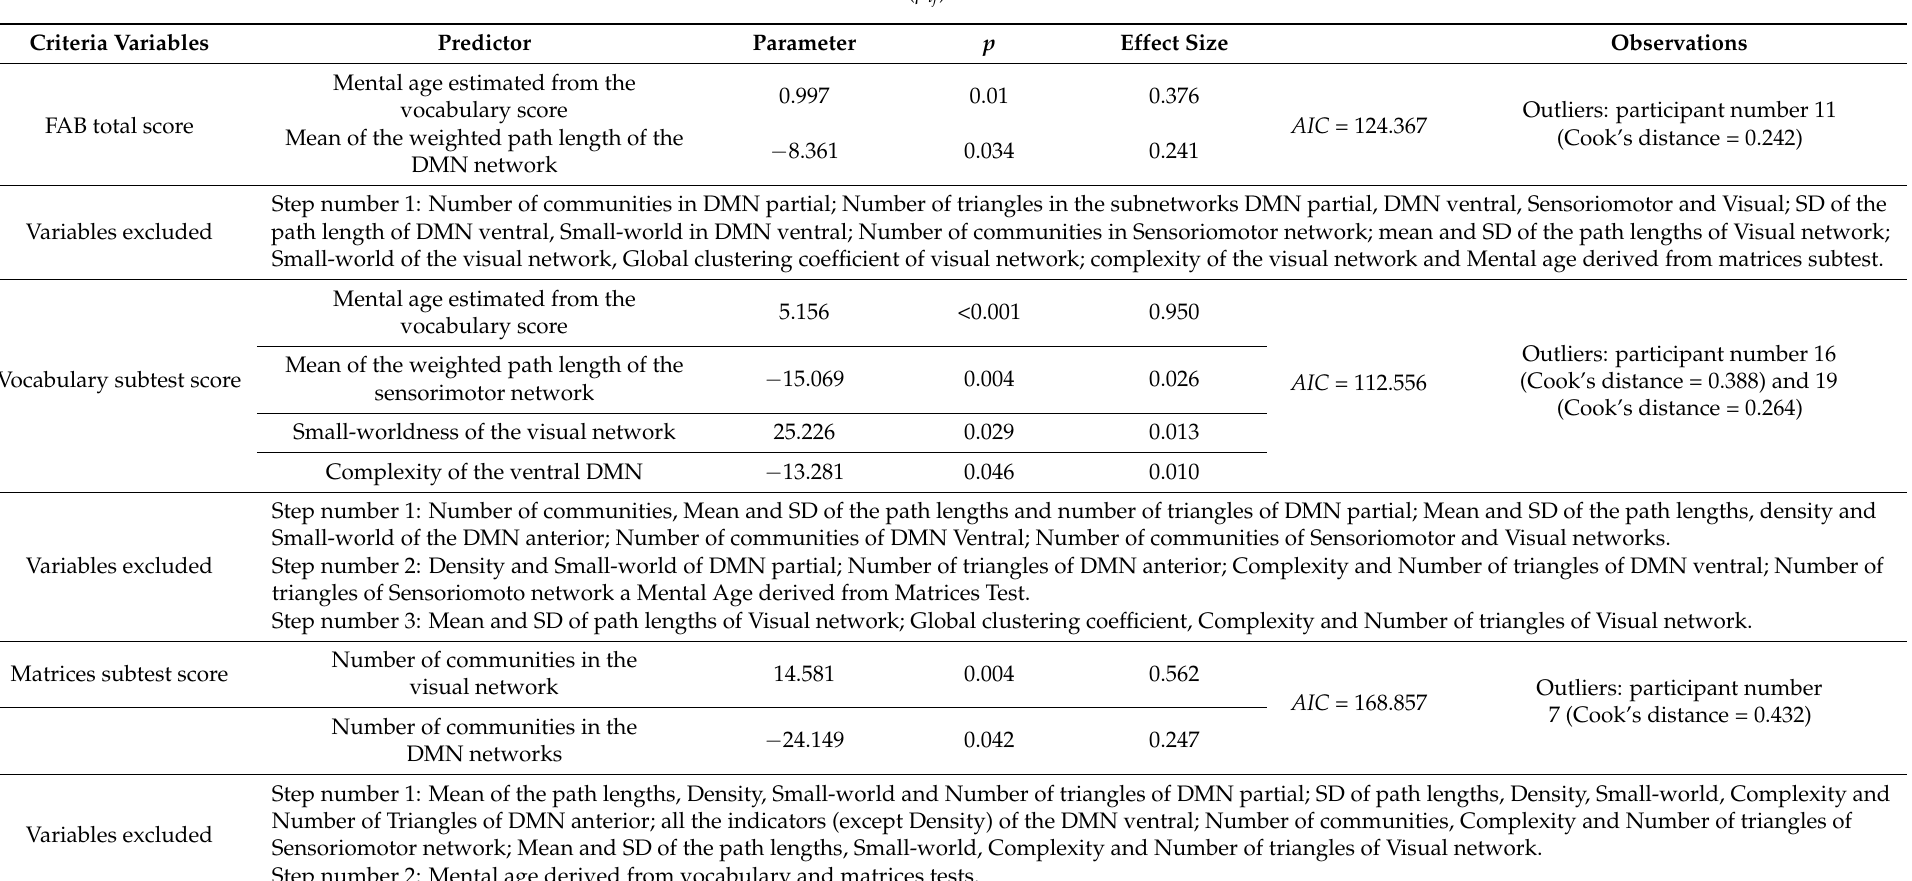
Table 6. Parameter estimation ( β ij ) for each of the criterion